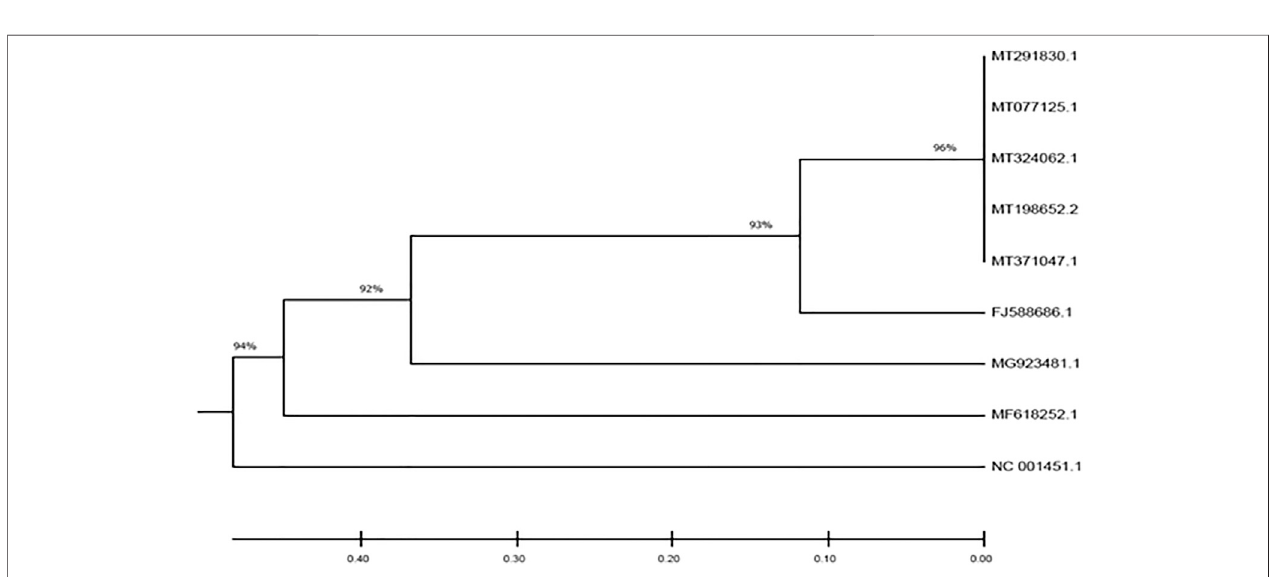
FIGURE 1 | Phylogenetic tree depicting the evolutionary relationships between the studied viral genomes.